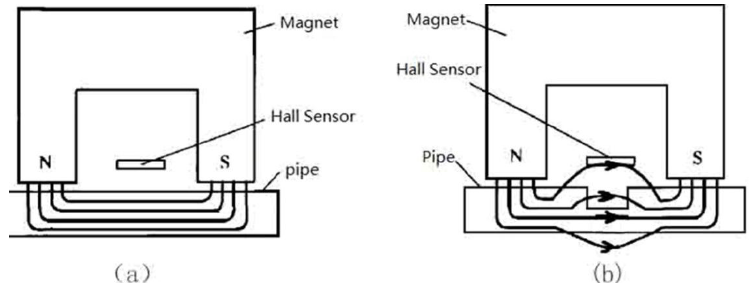
Figure 2. Principle of magnetic flux leakage detection. ( a ) Pipe without metal loss; ( b ) Pipe with defect.